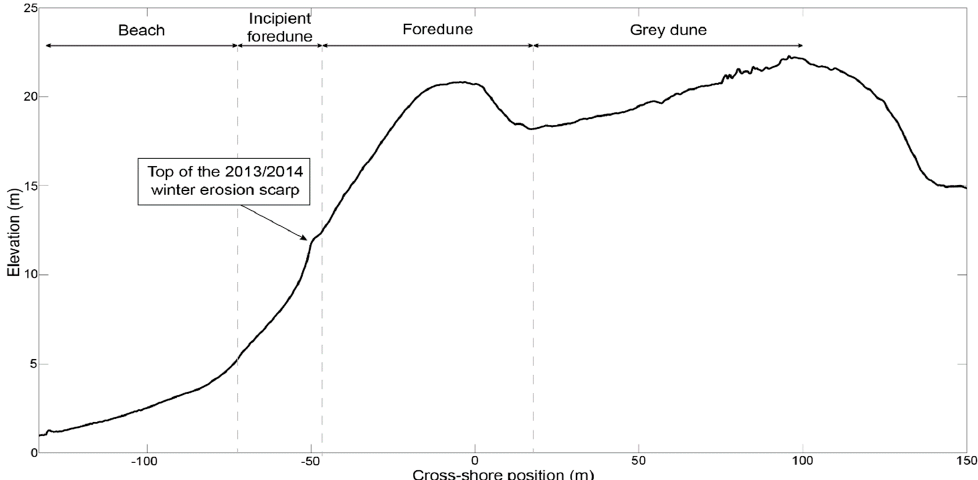
Figure 5. Cross-shore profile of the beach-dune system at Truc Vert showing the different morphological compartments with indication of the location of the 2013/2014 erosion scarp mark.